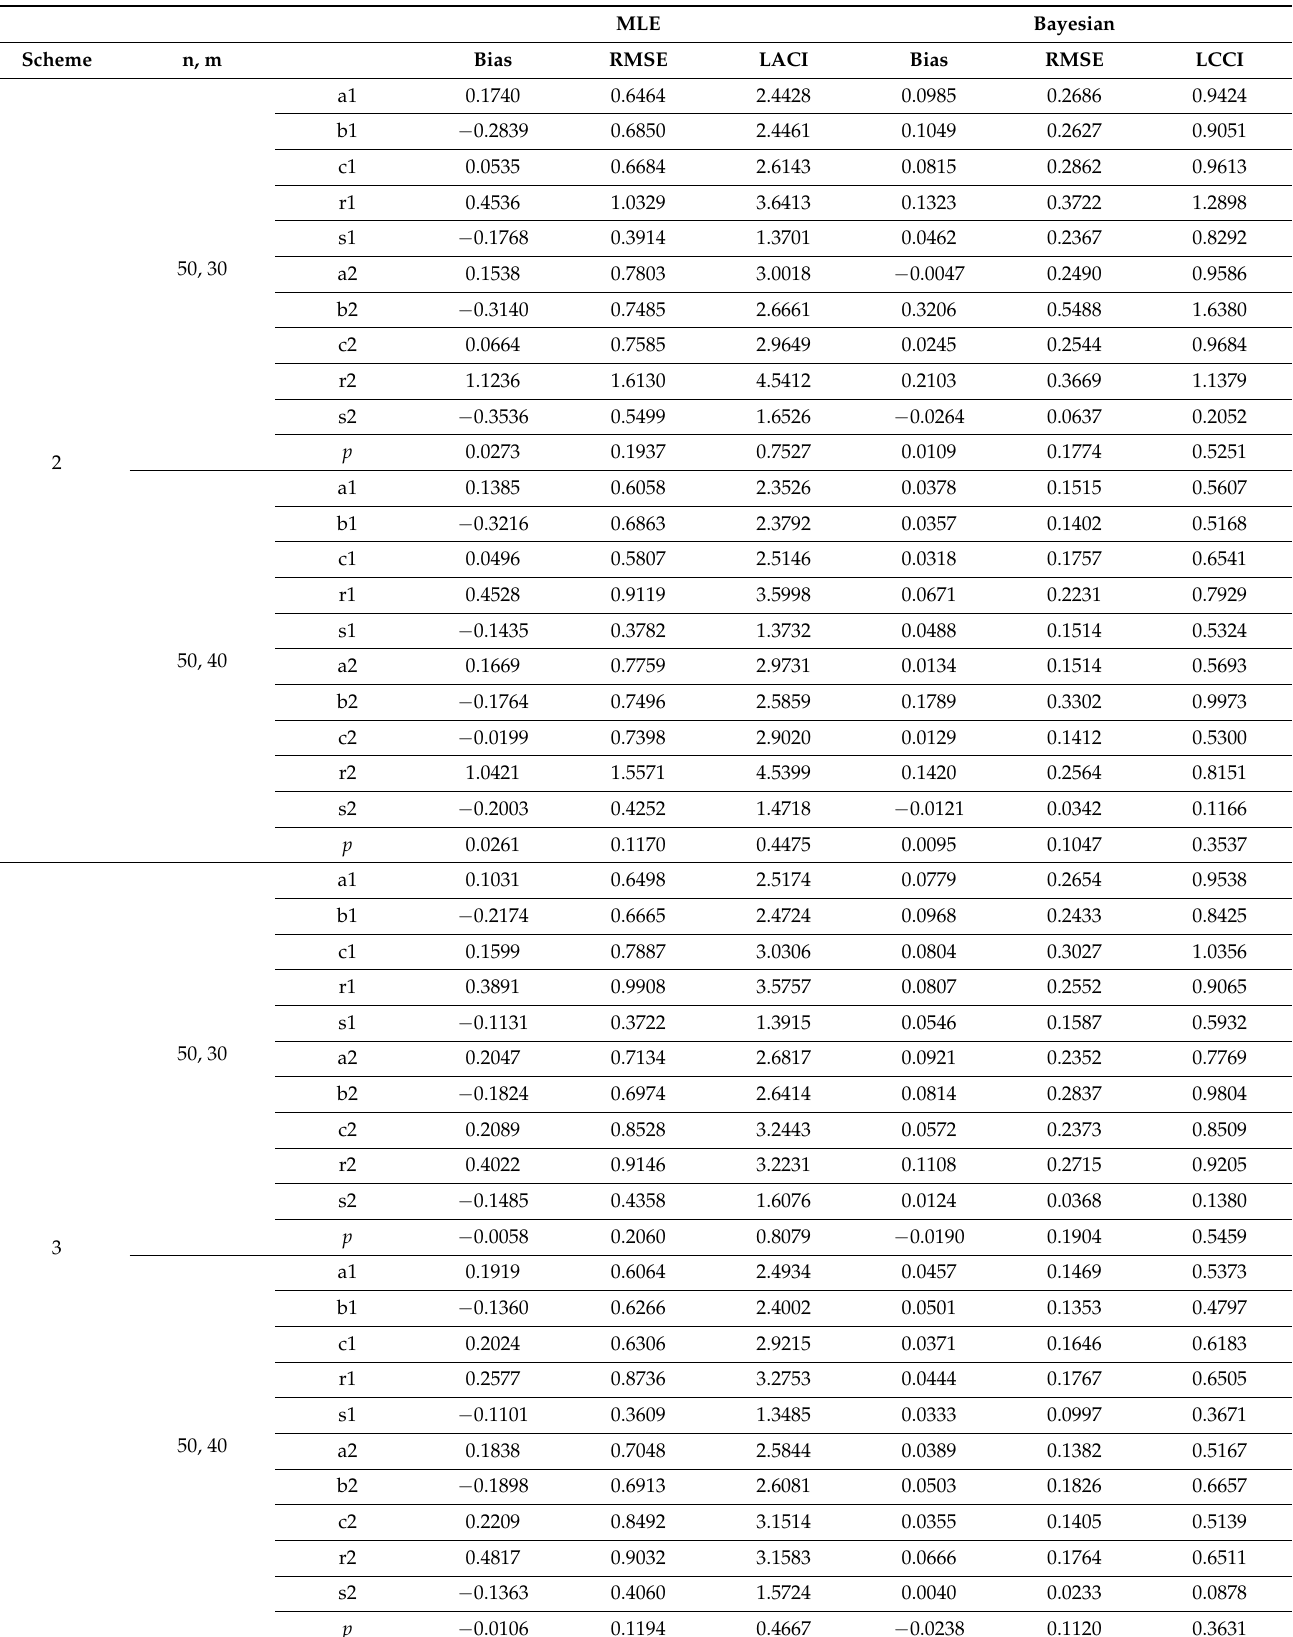
Table 4. Bias, RMSE and length of CI for the MLE and Bayesian estimates of the parameters are presented for different schemes: Case 1 and n =